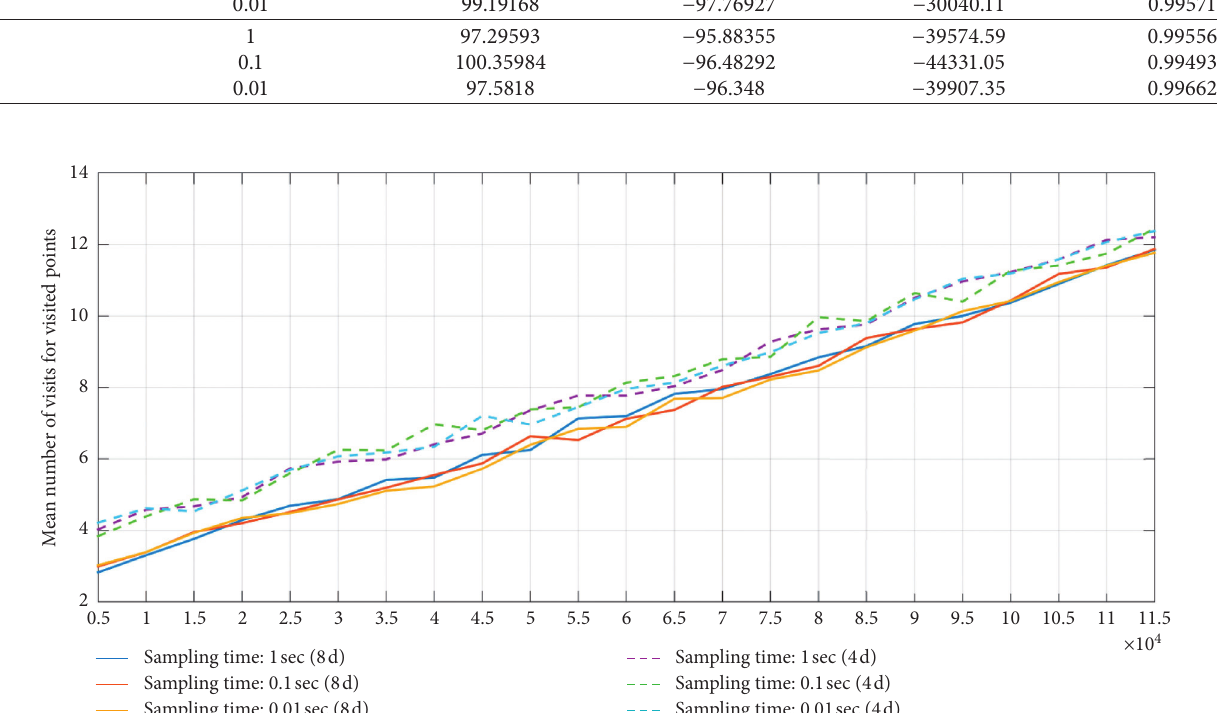
Figure 19: Mean number of visits per visited